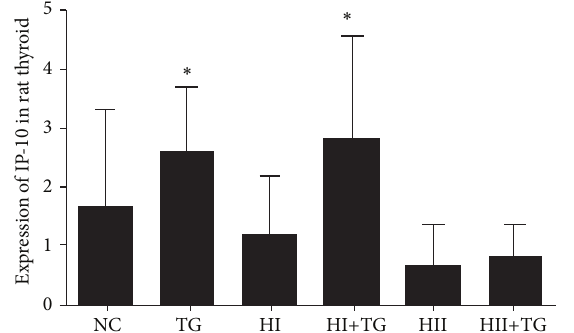
Figure 5: Bars in this figure show differential expression of IP-10 mRNA in the rat thyroid in each group. Expression of IP-10 mRNA in the thyroid tissues of rats in the HI and HI+TG groups was significantly higher than that in the NC